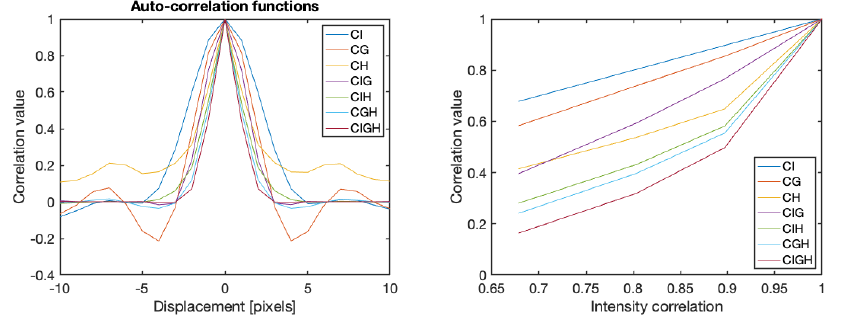
Figure 2. Sensitivity of the different correlation functions. The left image shows the width of the different auto-correlation functions as a function of displacement. The right image shows the decrease in maximum correlation value as a function of intensity correlation value. These results are generated according to the theory in Sections 2 and 3.1,